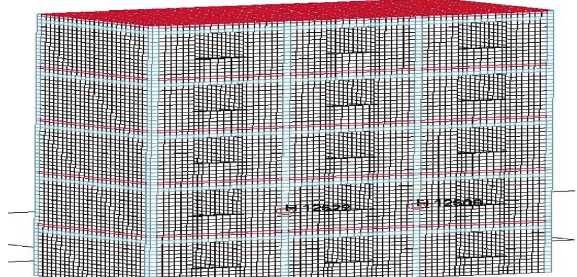
Figure 16: Initial space position of the flying stone element.